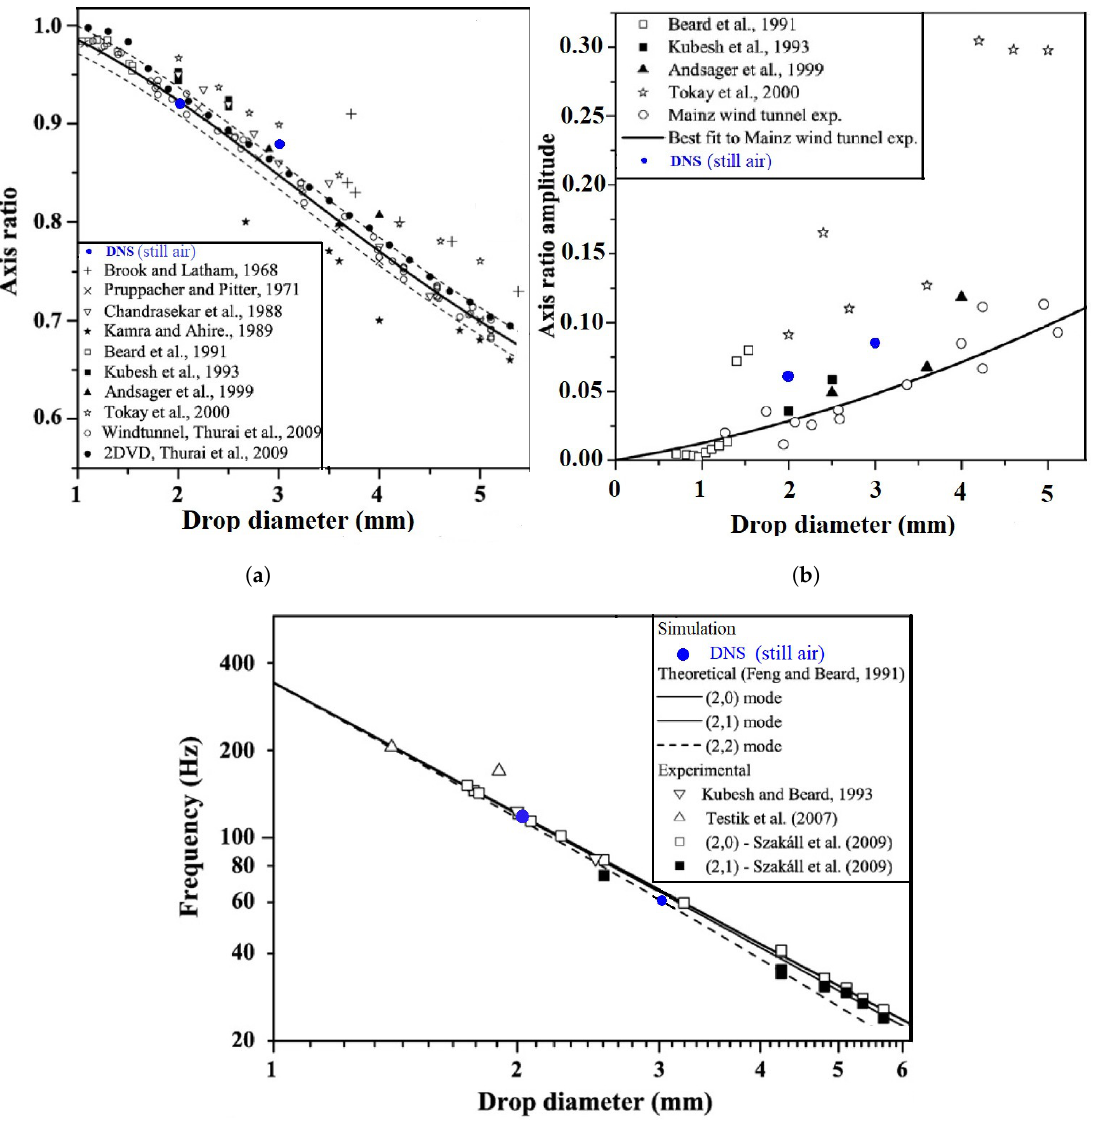
Figure A2. Comparison of the axis ratios, the axis ratio amplitudes and the oscillation frequencies of the simulated 3 mm and 2 mm water drops in stagnant air: ( a ) Axis ratio. ( b ) Axis ratio amplitude. ( c ) Oscillation frequency. The figure is adapted from